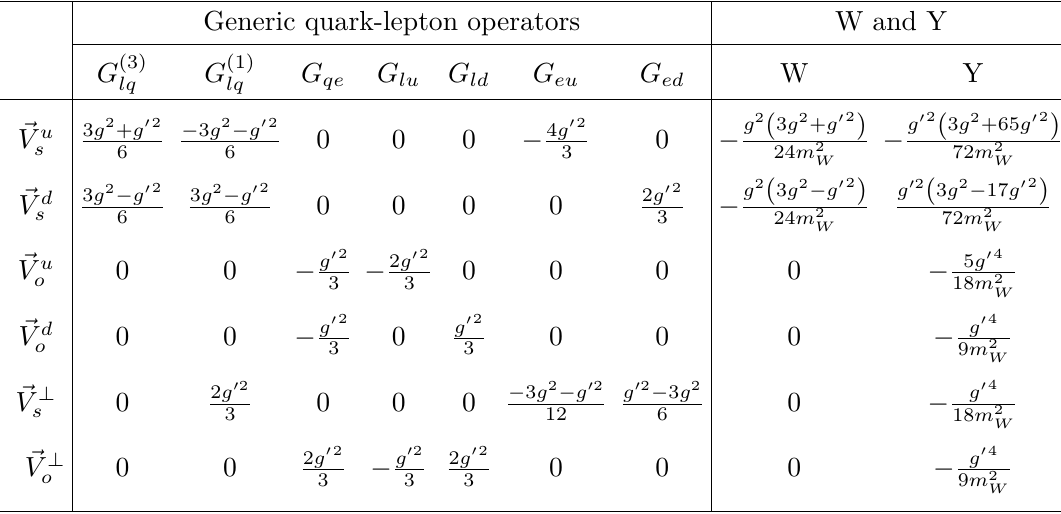
Table 8 . Explicit expressions for the components of the ~V q table gives the components along the generic quark-lepton operators in the Warsaw basis, while the last two columns correspond to the components along the W and Y